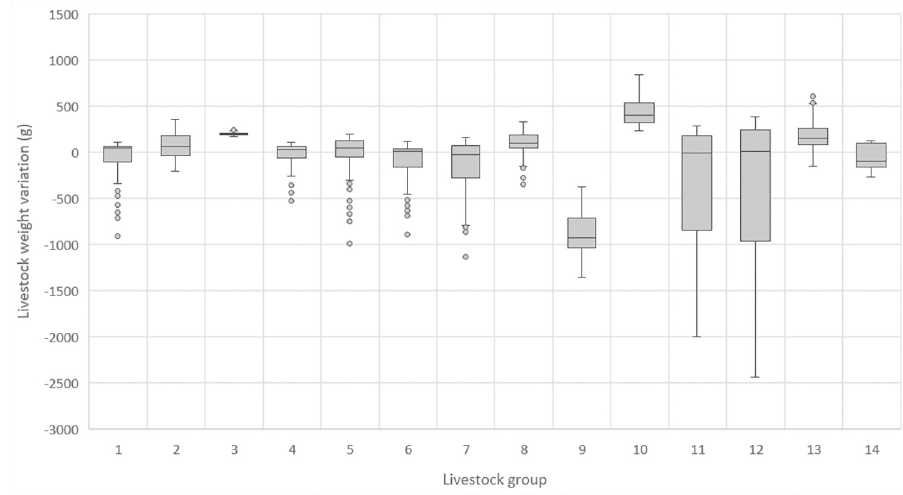
2. for tables, each table’s composition (Fig 15B); and 3. for parameterised models, the expression or algorithm used (Fig 15C).